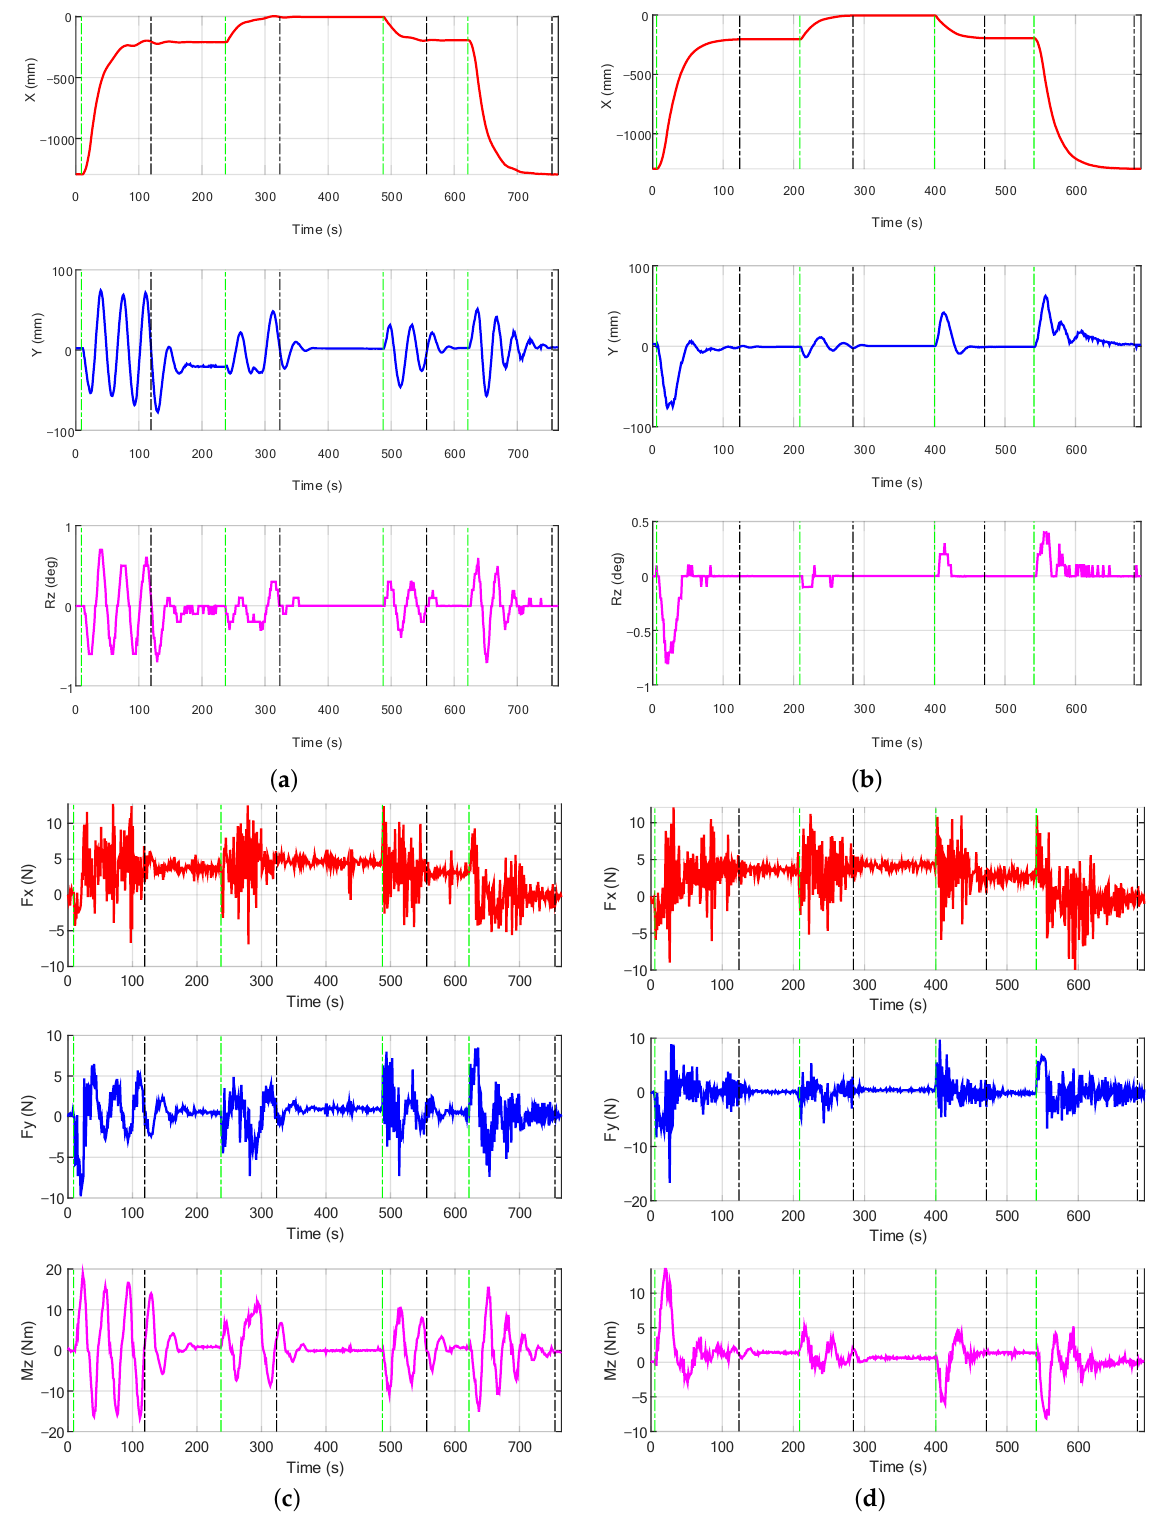
Figure 13. Comparison of the 1500 kg load visual servo with or without base FTS feedback. ( a ) The relative position of the visual servo without FTS feedback, ( b ) the relative position of the visual servo with FTS feedback, ( c ) the reaction torque form base FTS without FTS feedback, ( d ) the reaction torque form base FTS with FTS